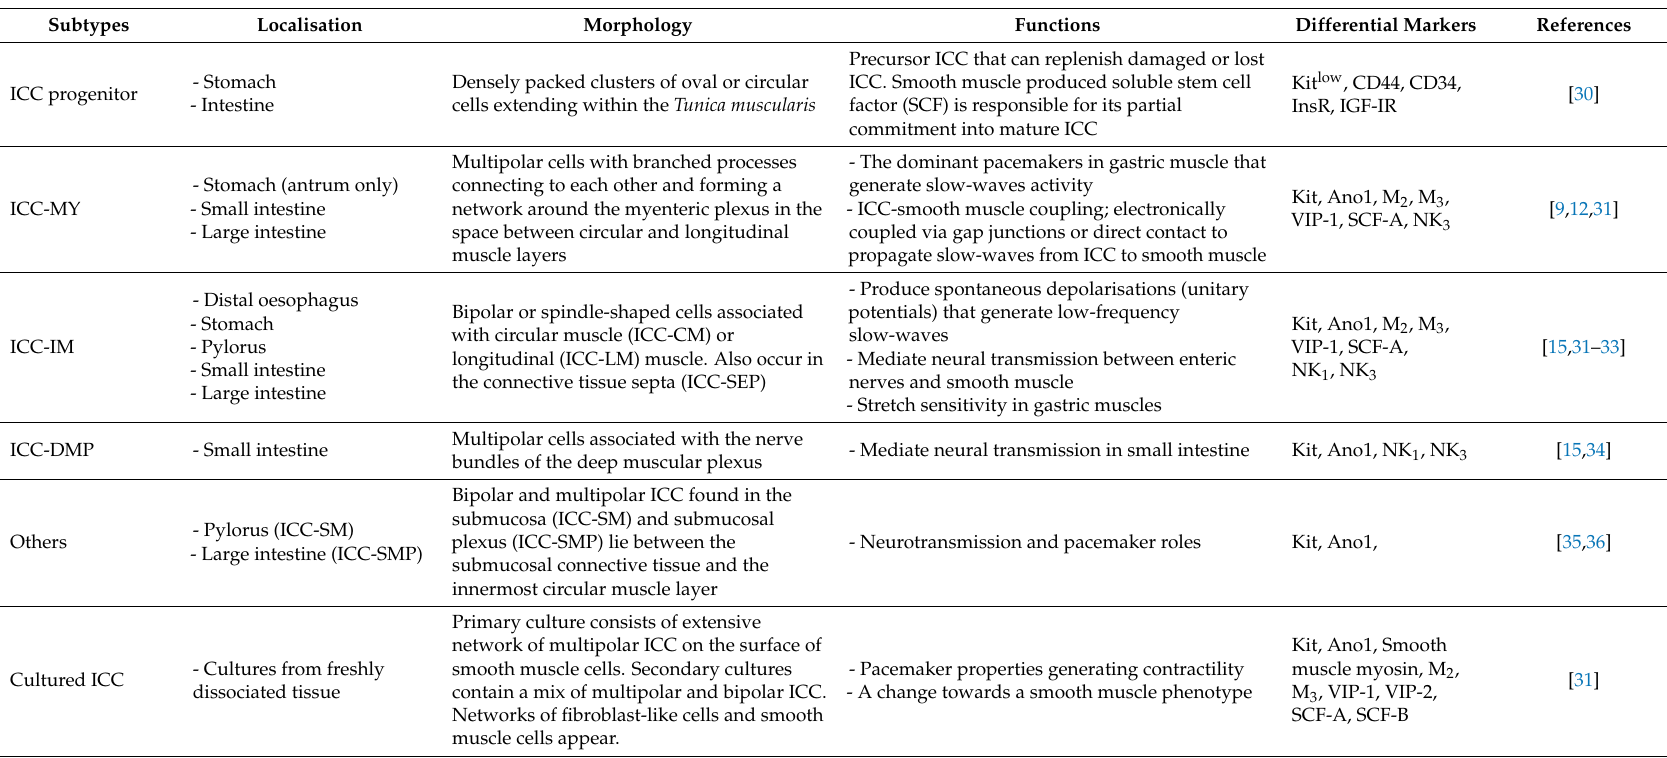
Table 1. Characteristics of interstitial cells of Cajal (ICC)